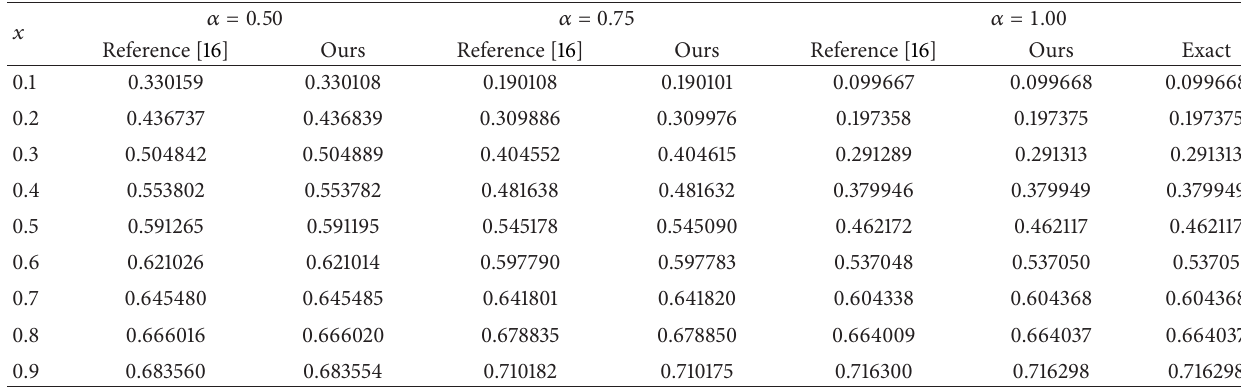
Table 1: Numerical results of Example 11 for 𝑚 = 9 in comparison to [16].